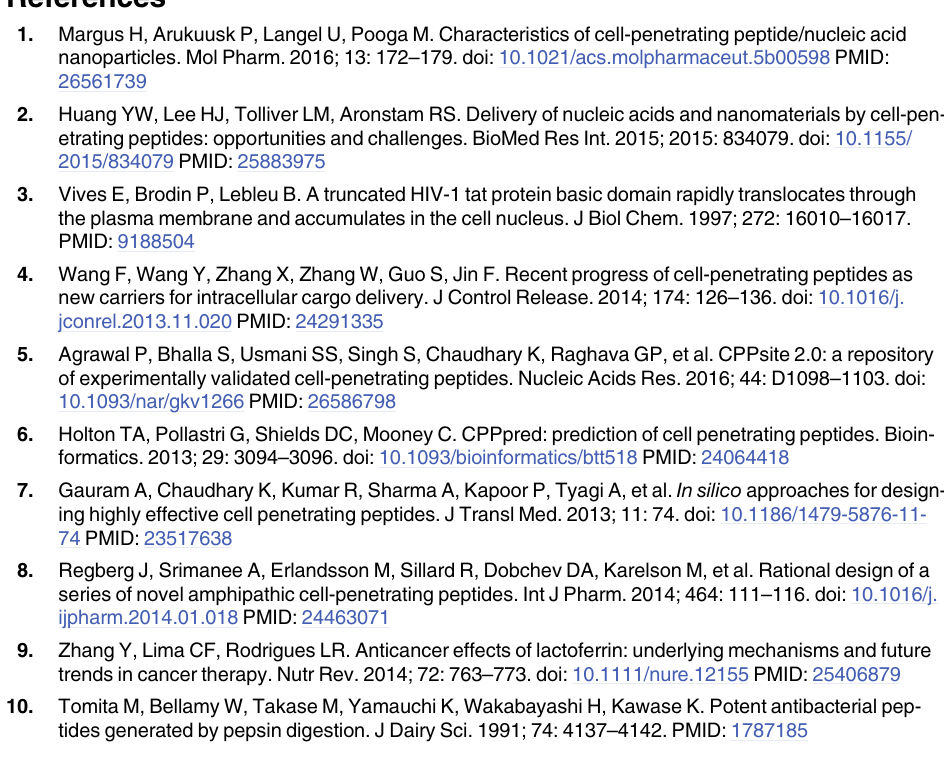
S1 Fig. Cellular internalization of FITC-labeled LFcins by dosage-dependent analysis. FITC-labeled LFcin derivatives at 0, 1, 5, 10, and 30 μ M concentrations were incubated with human A549 cells for 1 h before measuring cellular uptake using a flow cytometer. Cells with- out any treatment served as internal controls. Cells were treated with HR9-FITC and bradyki- nin-FITC as positive and negative controls, respectively. (TIF) S2 Fig. Cellular internalization of FITC-labeled LFcins by time-course analysis. Cells were treated with FITC-labeled LFcins of eight different lengths for 0, 5, 10, 20, 30 and 60 min. Cel- lular internalization ability was then analyzed using a flow cytometer.